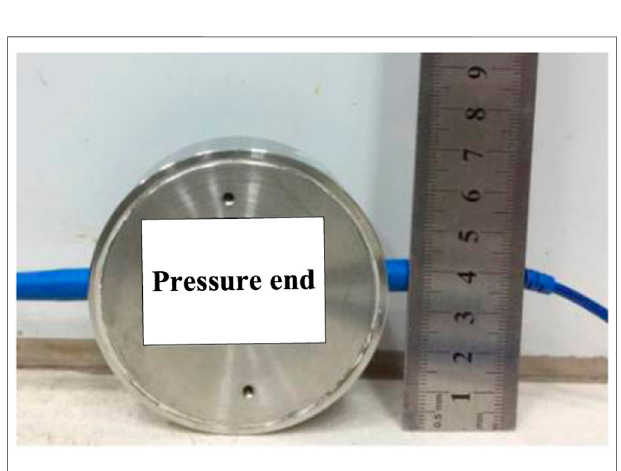
FIGURE 5 | Pile top pressure